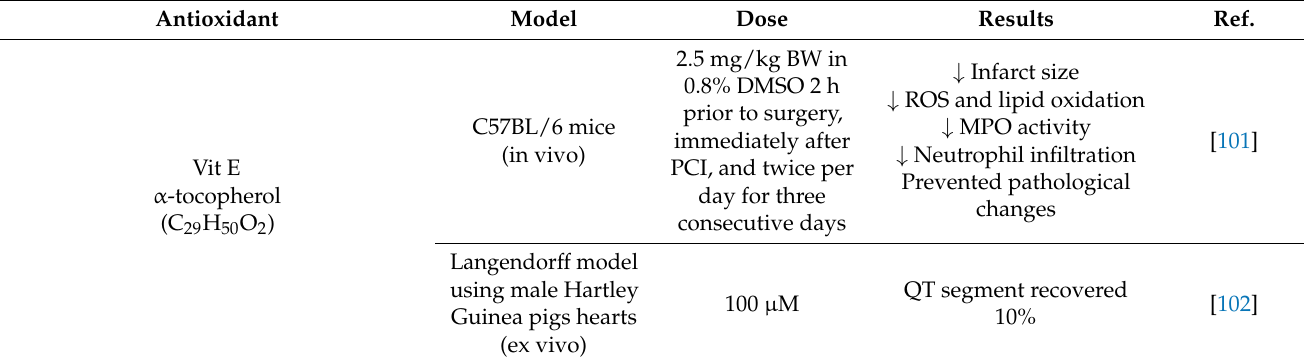
Table 2. Results of the use of different antioxidants to reduce